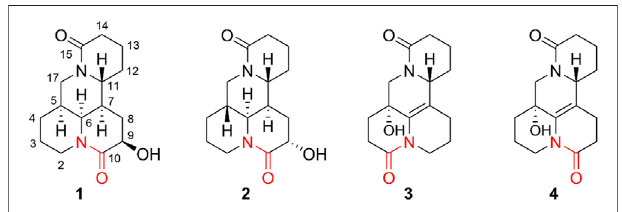
FIGURE 1 | Chemical structures of compounds 1 –